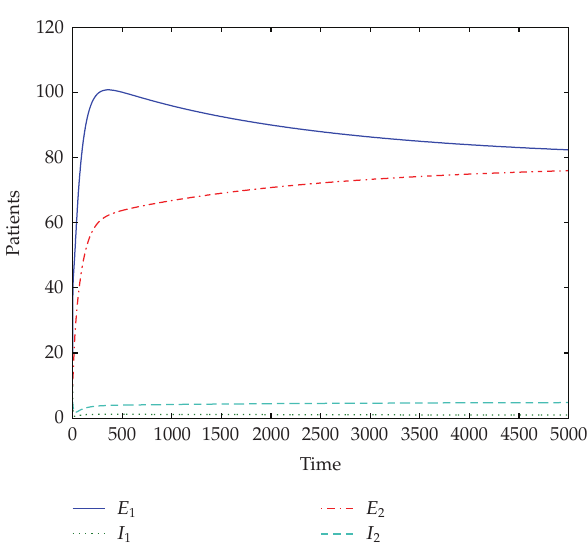
Figure 7: Trajectories of system (cid:2) 2.2 (cid:3) when β 1 (cid:2) N (cid:3) (cid:8) β 1 , β 2 (cid:2) N (cid:3) (cid:8) β 2 , β 1 (cid:8) 1, β 2 (cid:8) 0 . 25, d 1 (cid:8) 0 . 02, d 2 (cid:8) 0 . 07, so that R 1 > H , R 2 < f (cid:2) R 1 (cid:3) . It shows that the interior equilibrium P 2 is stable.